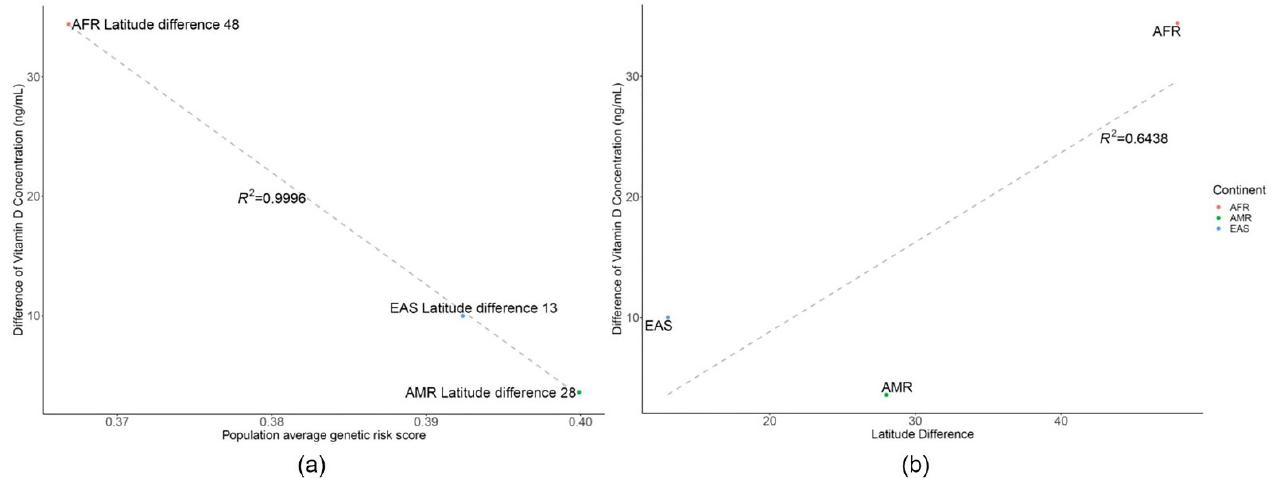
Figure 5. Correlation plot of the difference between vitamin D concentration and genetic risk score using related single- nucleotide polymorphisms or latitude. ( a ) The difference between vitamin D and genetic risk score, showing that a lower genetic risk score cannot compensate or generate vitamin D when this population is relocated to a higher latitude, where the regression R 2 is 0.9996. ( b ) Difference between vitamin D and latitude, showing that latitude difference does not impact the difference of vitamin D as much as genetic risk score, with an R 2 value of 0.6538. (AFR: African, AMR: American, EAS: East Asian).